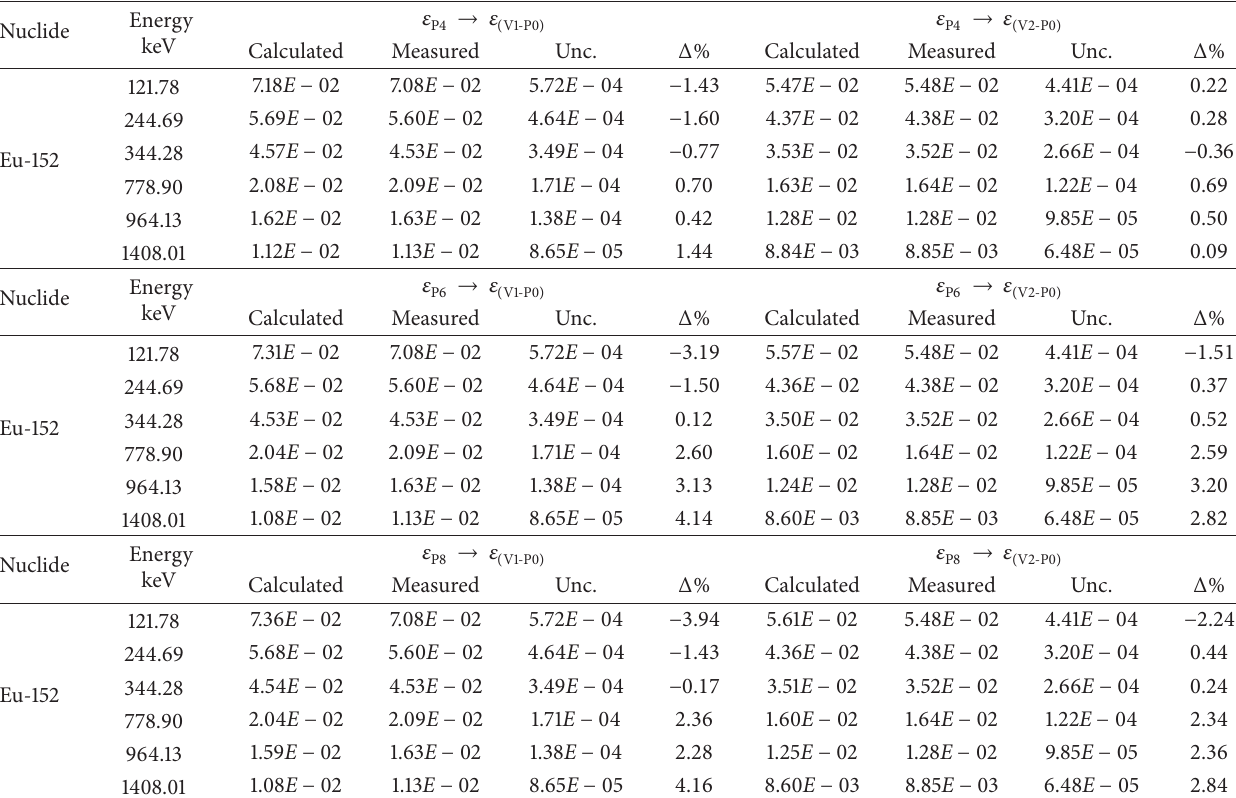
Table 7: Comparison between the measured and calculated full-energy peak efficiencies for parallelepiped sources, V 1 and V 2 , at position P 0 . Energy Nuclide keV Calculated Measured Unc. Δ % Calculated Measured Unc. Δ %